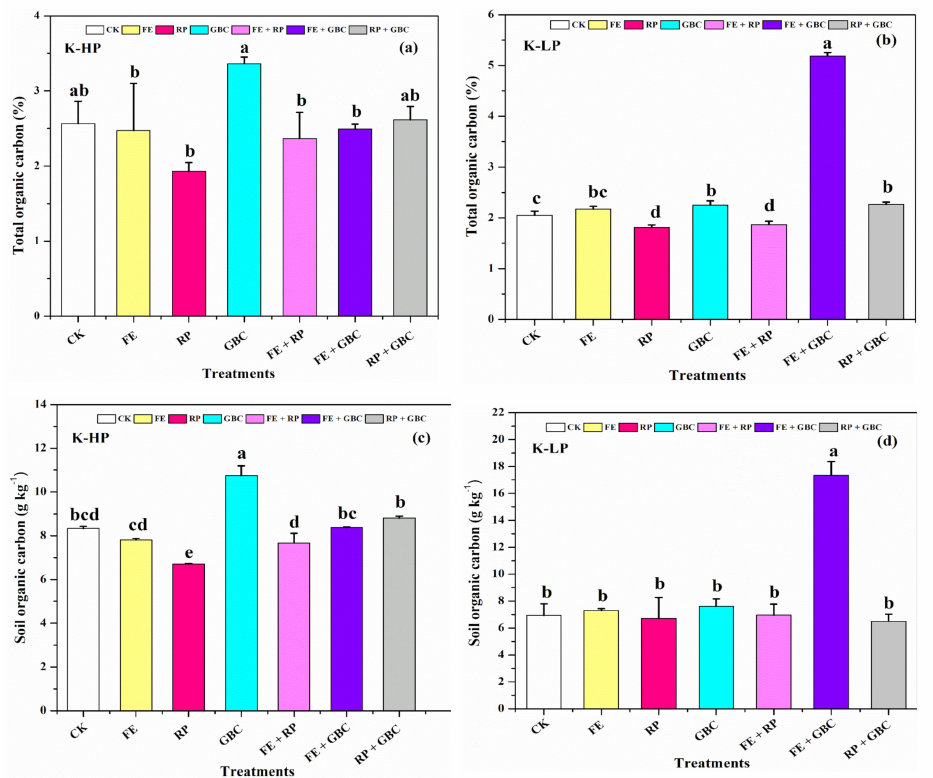
Figure 3. Influence of additives on total organic carbon ( a ) in K-HP, ( b ) H-LP; soil organic carbon, ( c ) in K-HP soil, and ( d ) in H-LP soil. The values in a given column followed by the same letter are statistically not significantly ( p < 0.05) using Tukey’s HSD test.